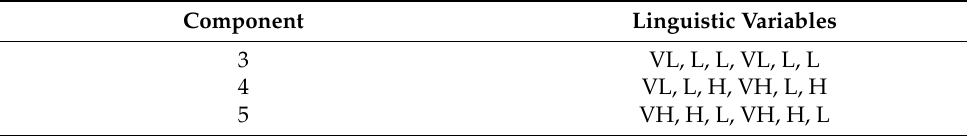
Table 5. Linguistic variables of six